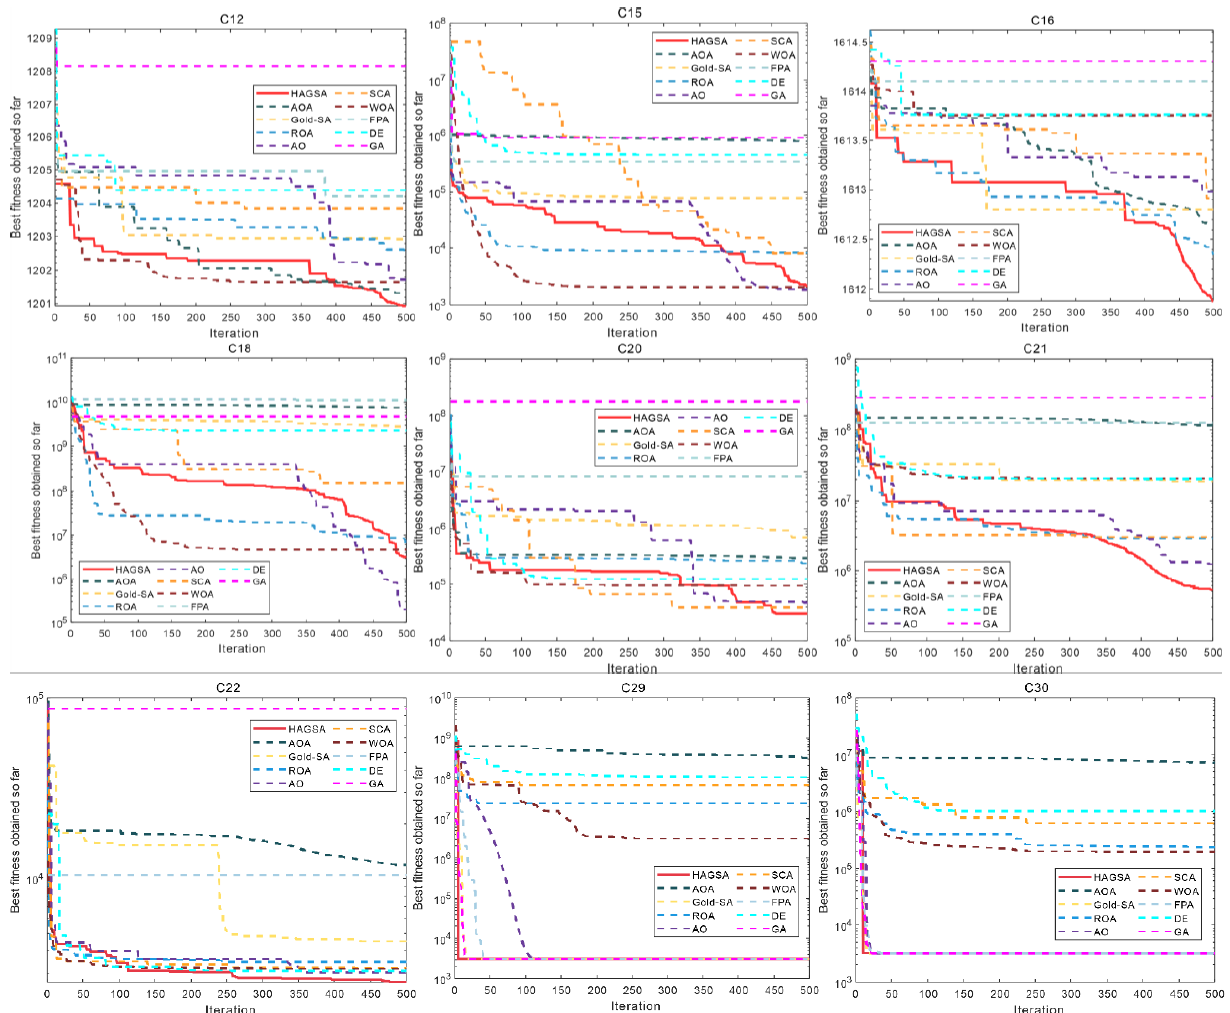
Figure 9. Convergence curve of algorithms on some functions.